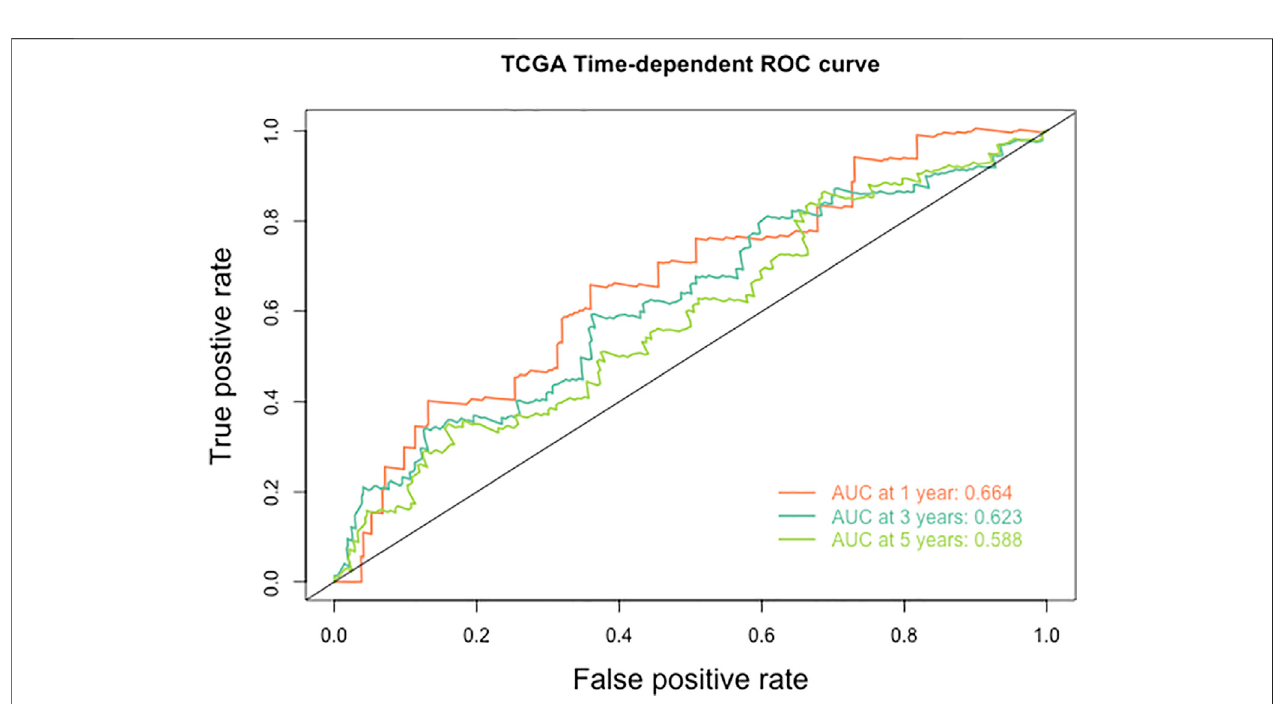
Frontiers in Genetics |